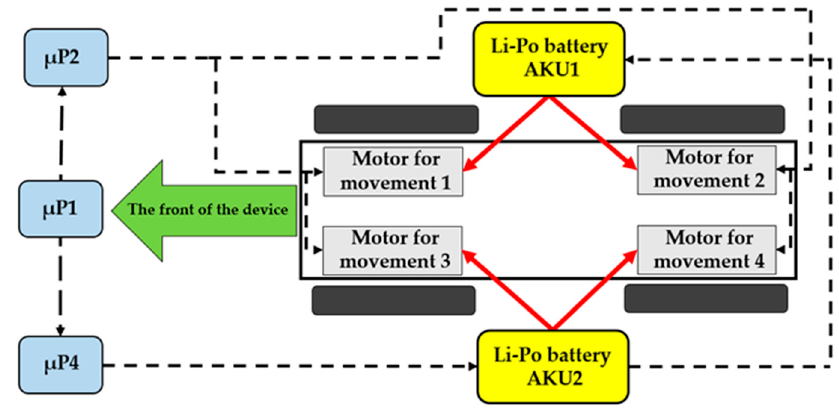
Figure 21. Block diagram of the Drive.